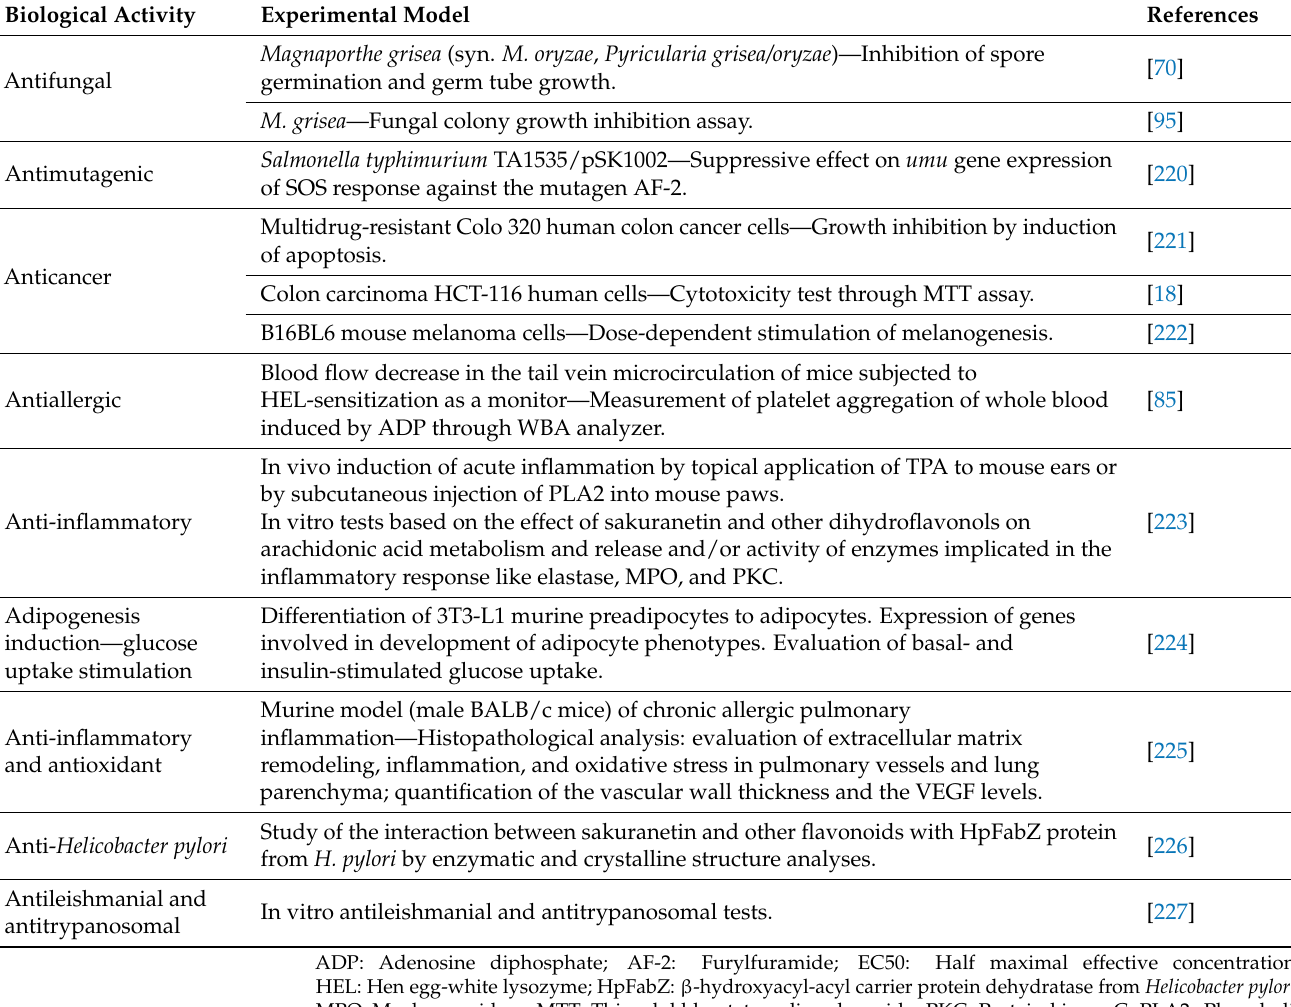
Table 5. Biological activities of